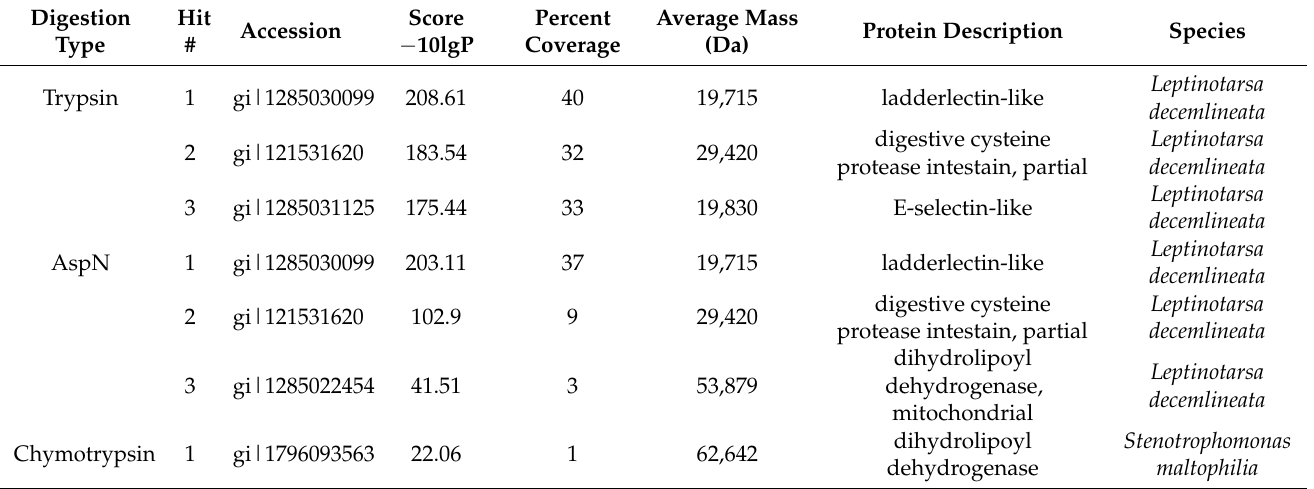
Table 2. PEAKS identification searches of protein spot 17 from CPB midgut, pH 4–7, 13 cm strip (cut to 7 cm). Digestion